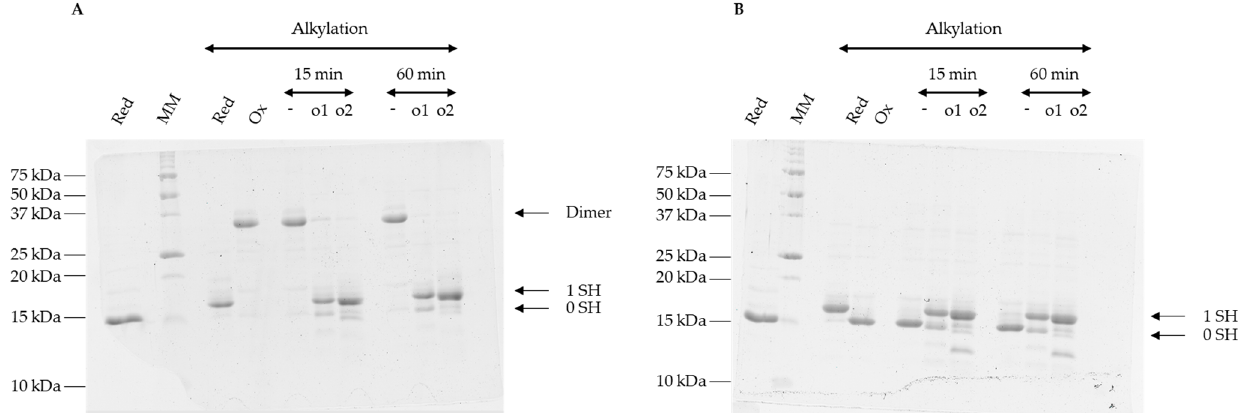
Figure 4. Reduction of oxidized At GRXS15 forms by mitochondrial thioredoxins. Pre-oxidized recombinant At GRXS15 (13 µM), either dimeric ( A ) or glutathionylated ( B ), was incubated with the reconstituted mitochondrial TRX system ( At TRX o1 or o2, At NTRB, NADPH) for 15 or 60 min. Remaining reduced thiols were then alkylated before sample migration on non-reducing SDS-PAGE. The numbers on the right correspond to the number of thiols that remained reduced upon treatment and thus were alkylated. Gels are representative of at least three independent experiments.